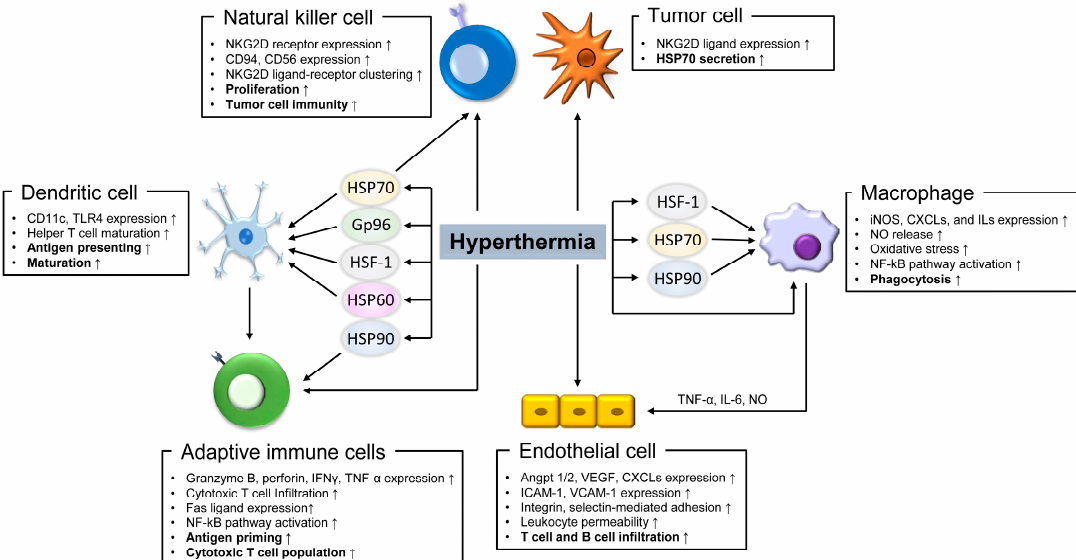
Figure 1. Hyperthermia-induced immunogenicity in immune cells. Diagram summarizes the effects of hyperthermia and heat shock proteins (Hsps) in immune response enhancement in macrophage, dendritic cell, natural killer cell, endothelial cell, adaptive immune cells, and tumor cell. VEGF: vascular endothelial growth factor; iNOS: inducible nitric oxide (NO) synthase; CXCLs: chemokine (C-C motif) ligands; ICAM-1: intracellular adhesion molecule 1; VCAM-1: vascular cell adhesion molecule 1; TNF- α : tumor necrosis factor α ; NKG2D: natural killer lectin-like receptor gene 2D. HSP: heat shock proteins; TLR: toll-like receptor; ILs: interleukins. The arrows indicate the upregulation effect by hyperthermia.